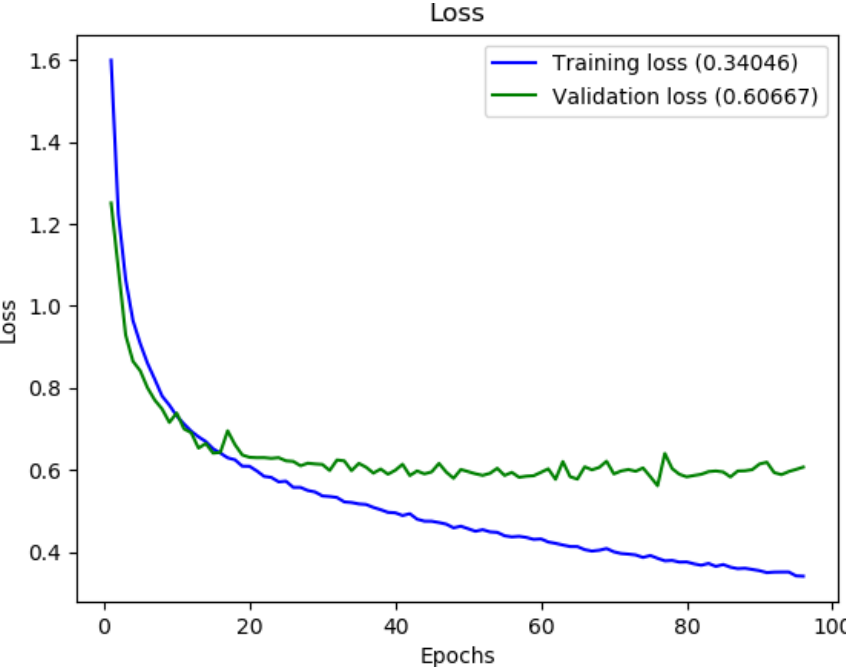
Figure 9. Loss graph of the network in [21], trained with the Ensemble 1 using the data augmentation and the z-score normalization. Figure from [35].